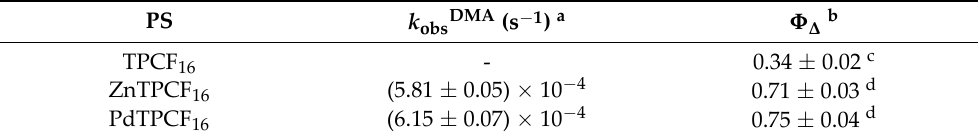
duction, c from ref. [18], d using MB as a reference: k obs = (4.26 ± 0.04) × 10 − 4 s − 1 , Φ Δ = 0.52 [22].